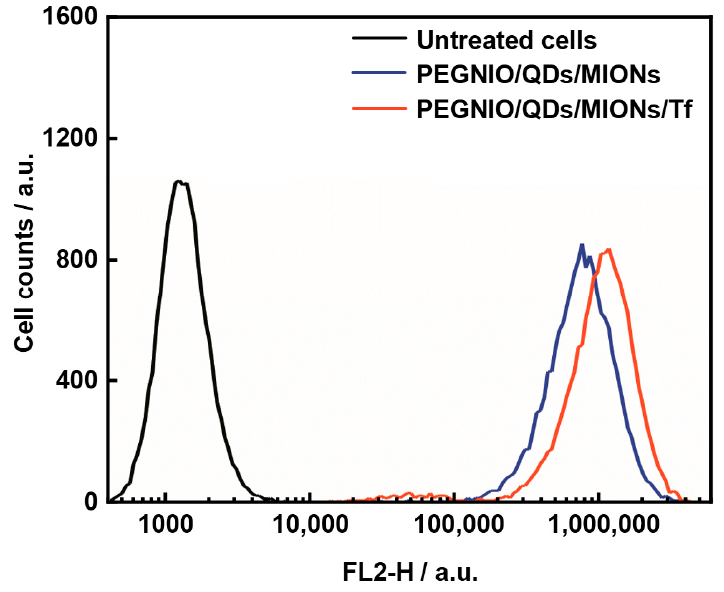
Figure 5. Flow cytometric measurement of the uptake of PEGNIO/QDs/MIONs and PEGNIO/QDs/MIONs/Tf by U87 cells.